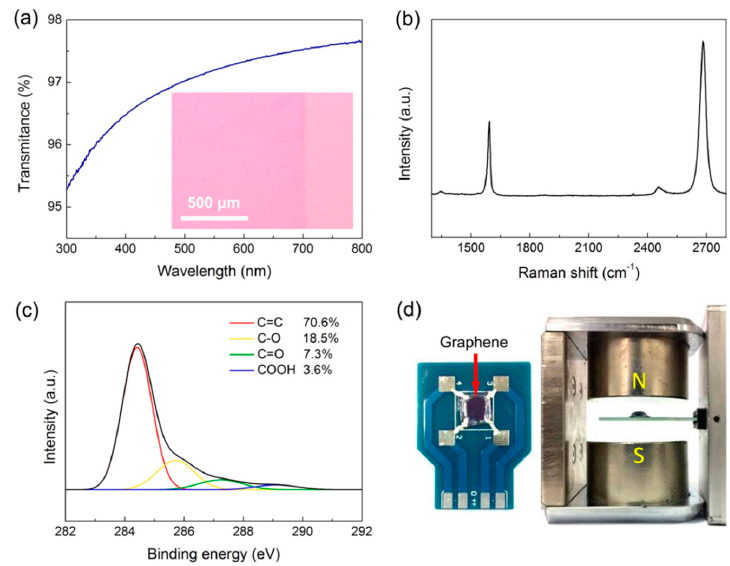
Figure 1. ( a ) The visible light transmittance of CVD graphene films. Inset: OM image; The corresponding ( b ) Raman and ( c ) high-resolution XPS C1s spectra; ( d ) Photograph of the graphene device measured based on the Van der Paul configuration.